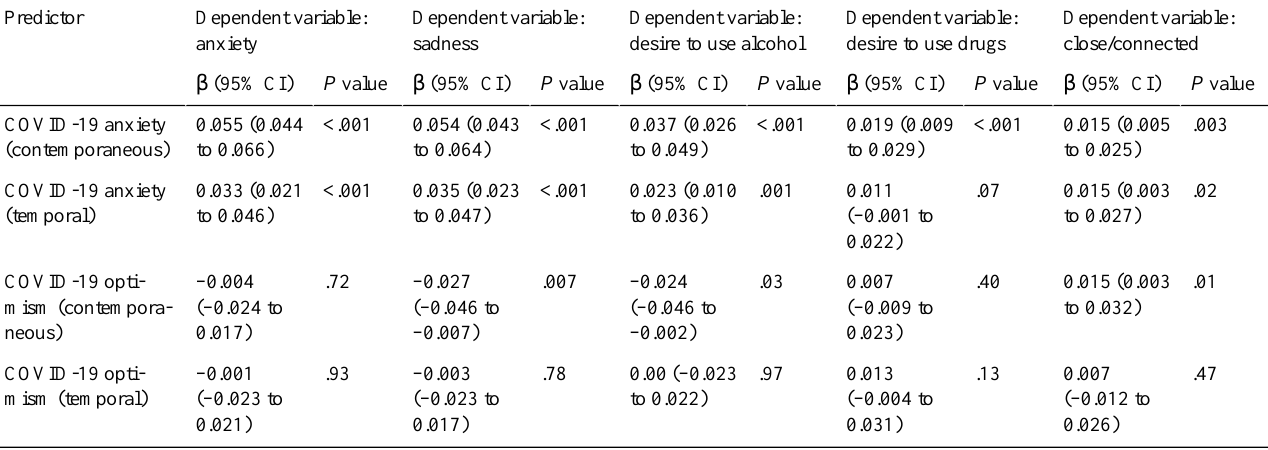
Table 2. Contemporaneous and short-term temporal associations between anxiety/optimism about COVID-19 and mental health, behavioral health, and connectedness dependent variables a